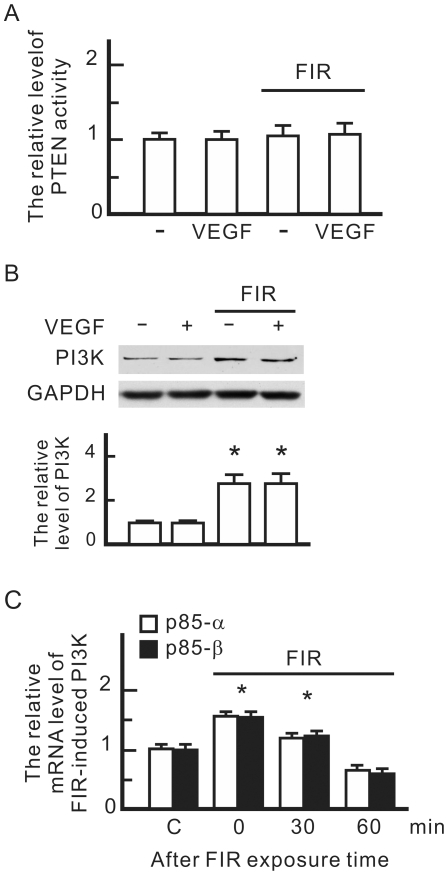
The influence of FIR on the PI3K signaling pathway in HUVECs.(A) FIR exposure-influenced phosphatase and tensin homolog (PTEN) activity. HUVECs were treated with vascular endothelial growth factor (VEGF) (10 ng/ml) or FIR exposure as indicated for 30 min. PTEN activity in each sample was detected by PTEN Malachite Green Assay Kit. The relative level of FIR-induced PTEN activity is shown as the mean±S.D. from six experiments. (B) Western blotting of PI3K p85. GAPDH was detected as a loading control. (C) FIR exposure-induced RNA levels of PI3K p85. HUVECs were pretreated with FIR exposure for 30 min, and then cultured for the indicated periods. The mRNA quantity of PI3K in each sample was detected by a qPCR with specific primers for the PI3K subunits p85α and p85β. The relative mRNA level of FIR-induced PI3K is shown as the mean±S.D. from six experiments. C, control. * p<0.05 vs. the control without FIR exposure.